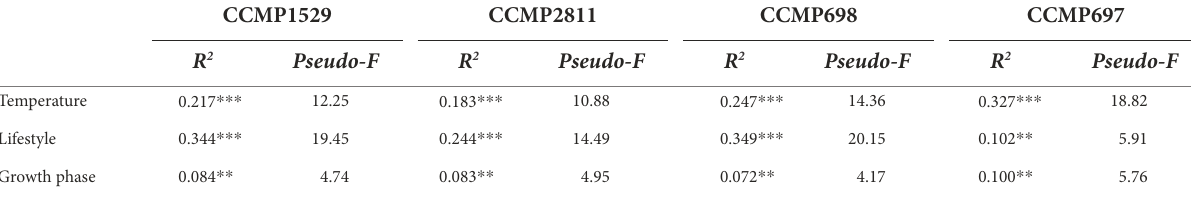
TABLE 2 Influence of temperature, lifestyle and growth phase on beta-diversity of bacterial communities of four Prorocentrum cordatum strains.